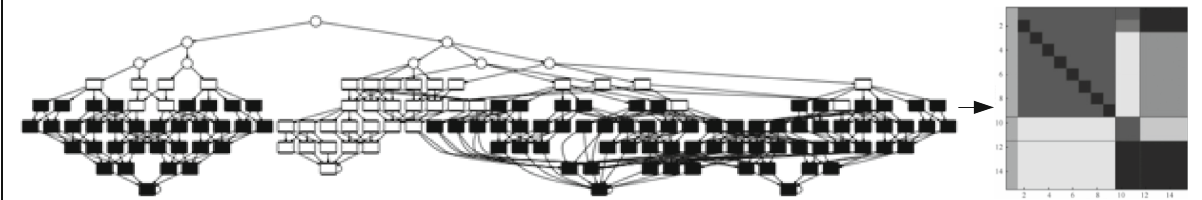
Fig. 14 Attack graphical analysis [140] and visualize simplified